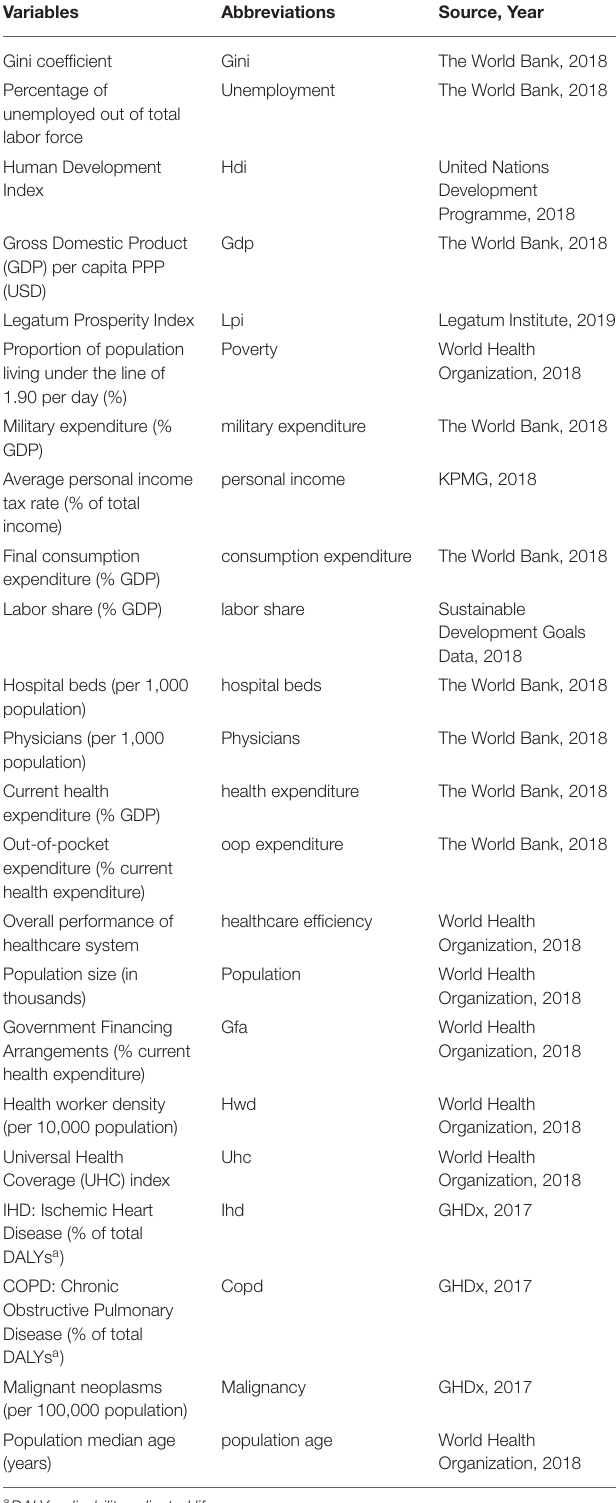
TABLE 1 | Selected variables and